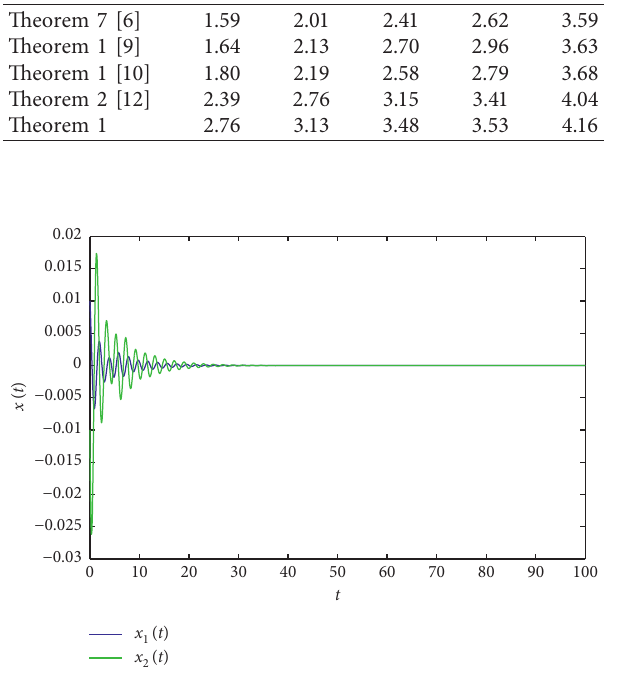
Figure 2: The state trajectories of system (1) for Example